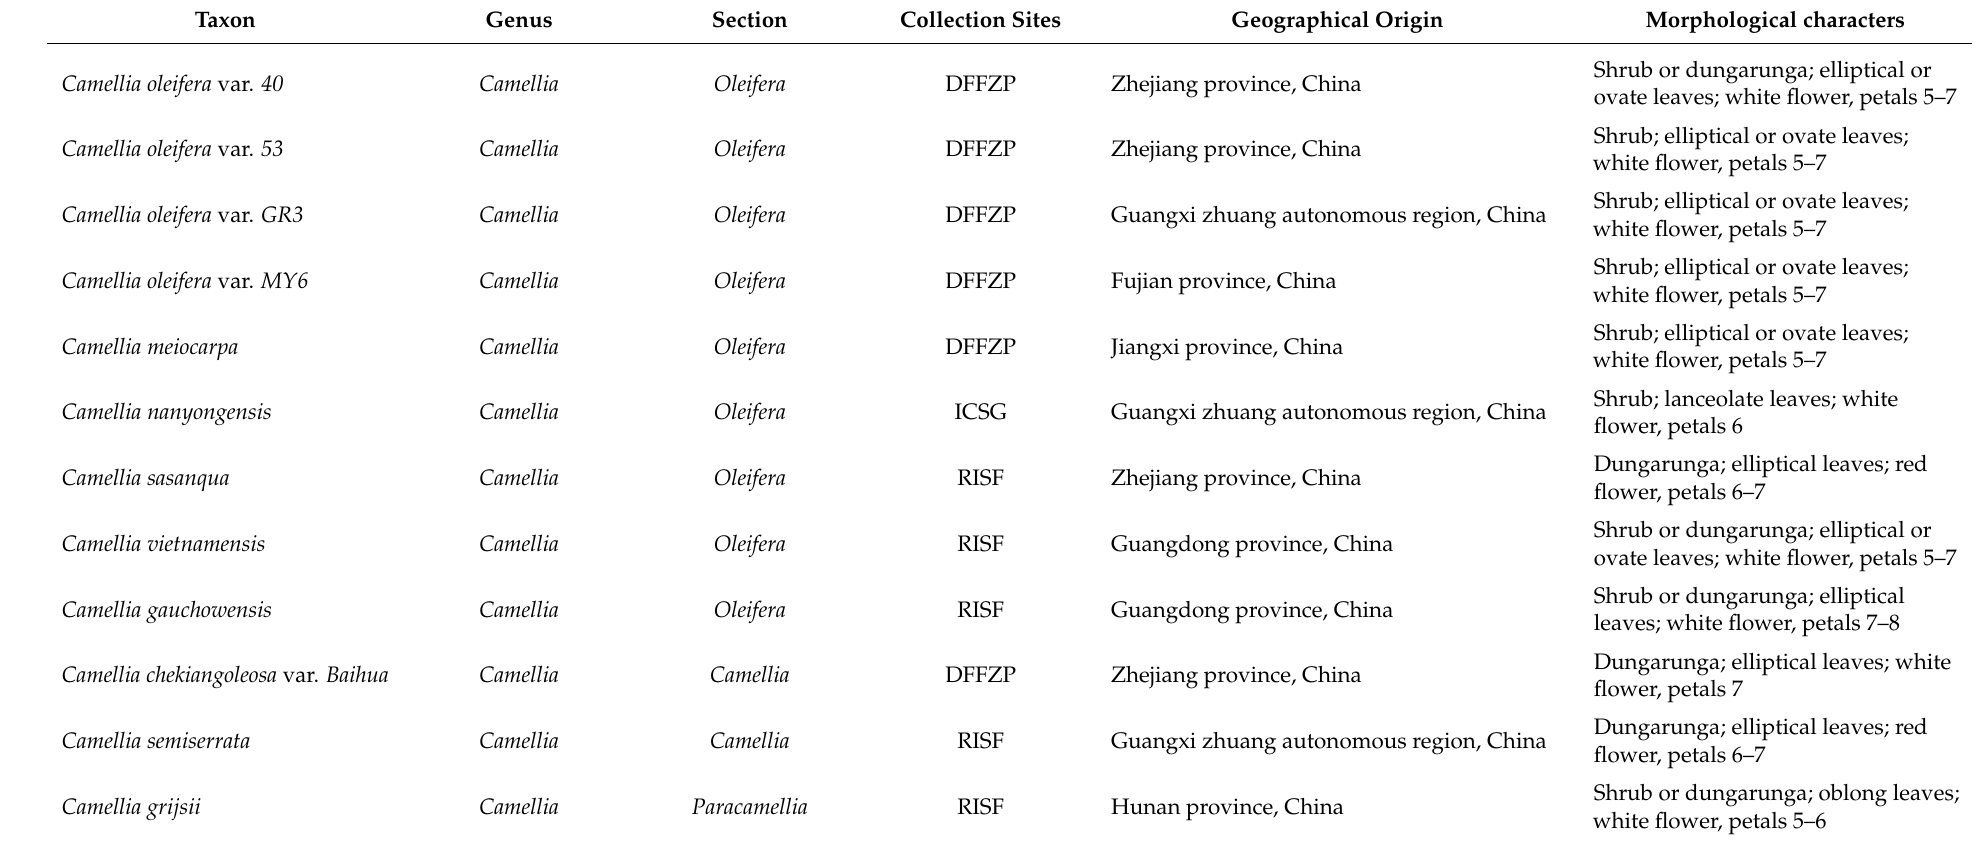
Table 1. Information of the sequenced oil–Camellia chloroplast genomes according to Sealy’s taxonomic